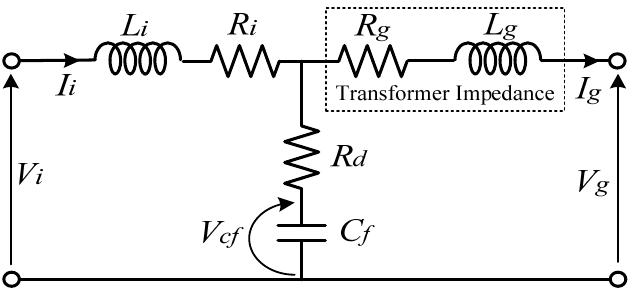
Figure 4. Single phase LC filter equivalent